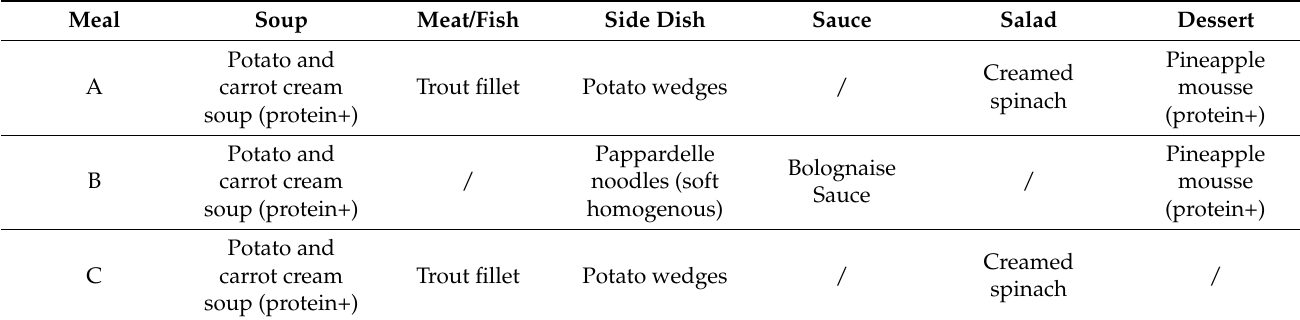
Figure 4. An example of exported pdf file from the kitchen database for the dish “Broccoli”: ( a ) the quantity of a normal- sized dish; ( b ) the macronutrients of a normal-sized dish (P: protein, F: fat, FA: fatty acids, CHO: carbohydrates).